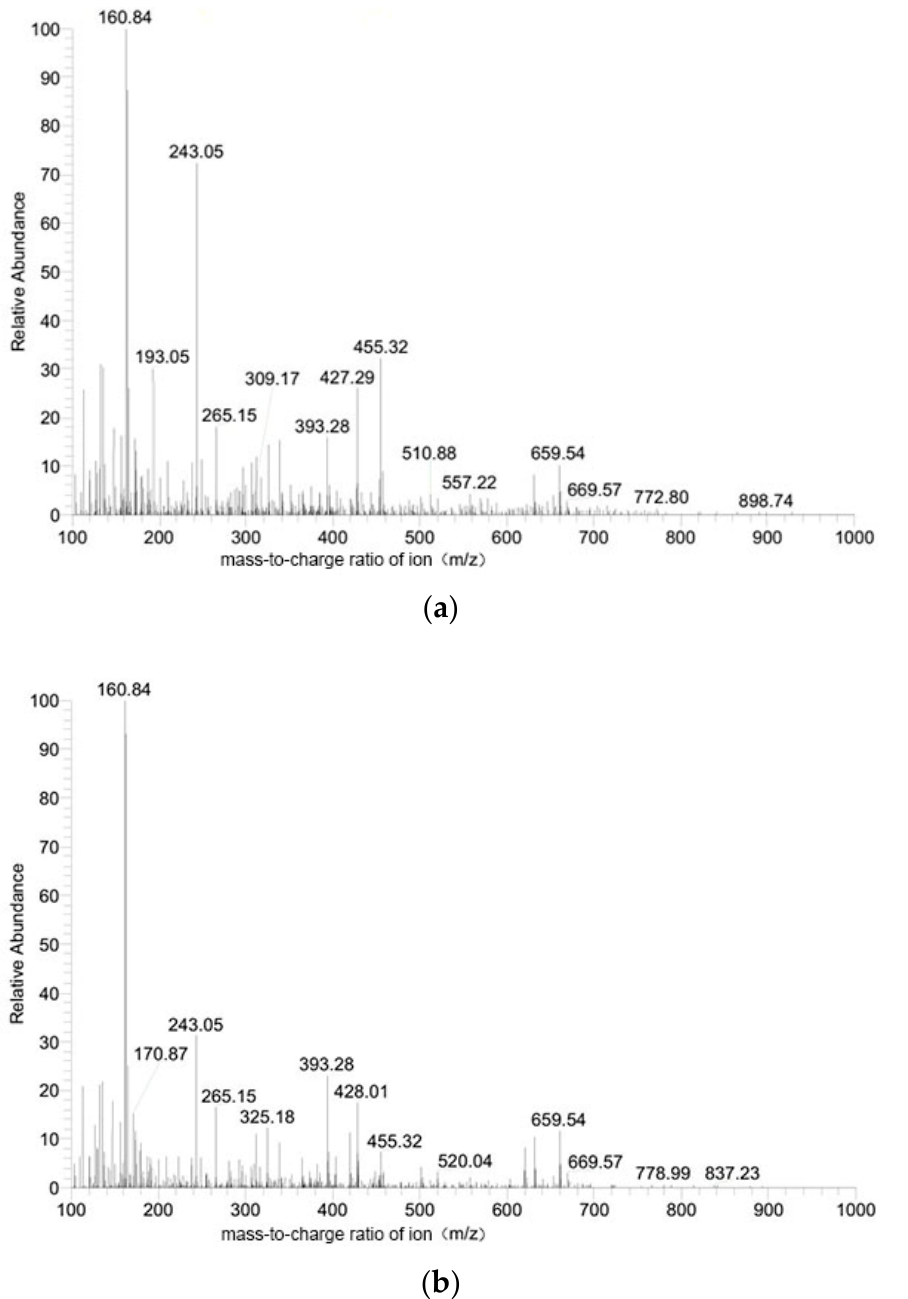
Figure 6. Liquid chromatography-mass spectrometry of the photodegradation productions of ( a ) PLA, ( b ) COF-PLA.3.6. Thermal Stability Analysis of the Synthetic Materials.